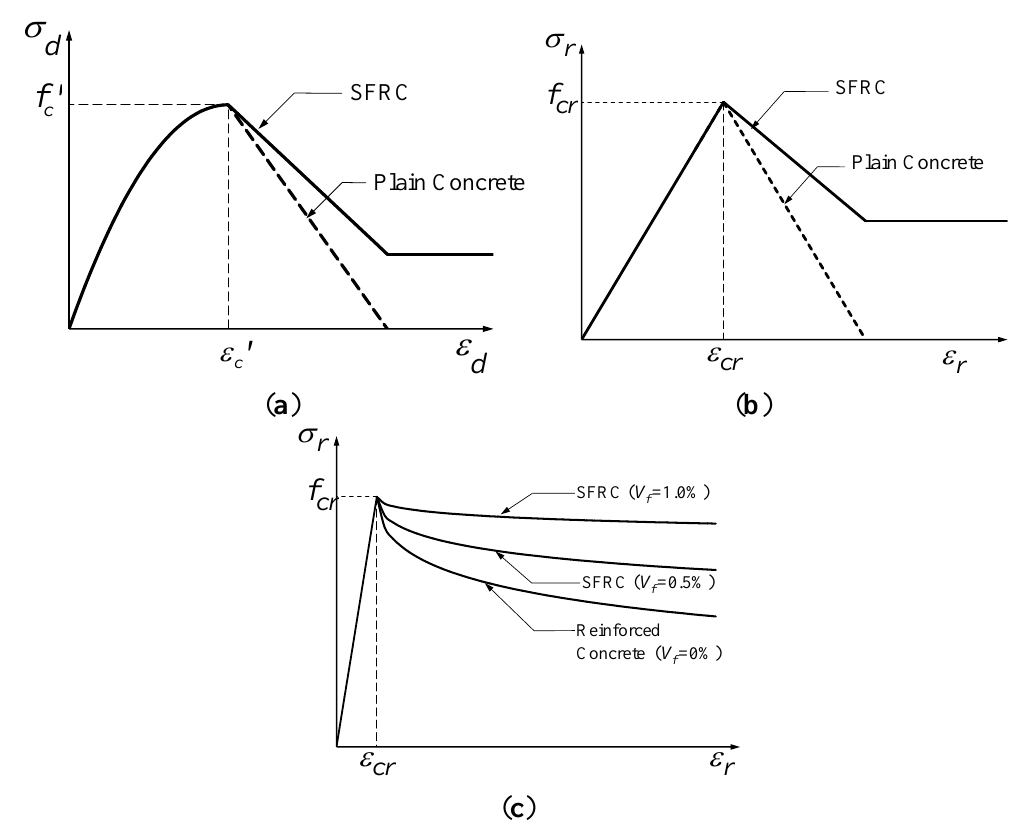
Figure 1. Constitutive models modified by Tan et al. ( a ) Compressive stress-strain relationship for rotating angle softened truss models (RA-STM) modified by Tan et al. [21]; ( b ) Tensile stress-strain relationship for RA-STM modified by Tan et al. [21]; ( c ) Tensile stress-strain relationship for modified compression field theory MCFT modified by Tan et al.